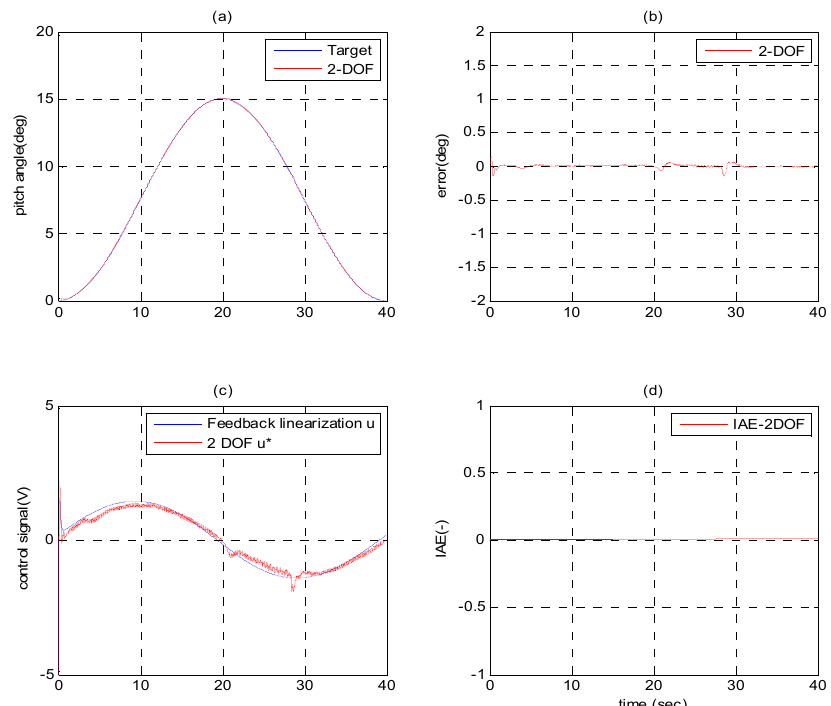
Figure 10. Experimental results of sinusoid path control of pitch angle with, amplitude 15°, period 40 s with no load: ( a ) Pitch angle response; ( b ) Pitch angle error; ( c ) Comparison of control signals; ( d ) Integral of absolute error.